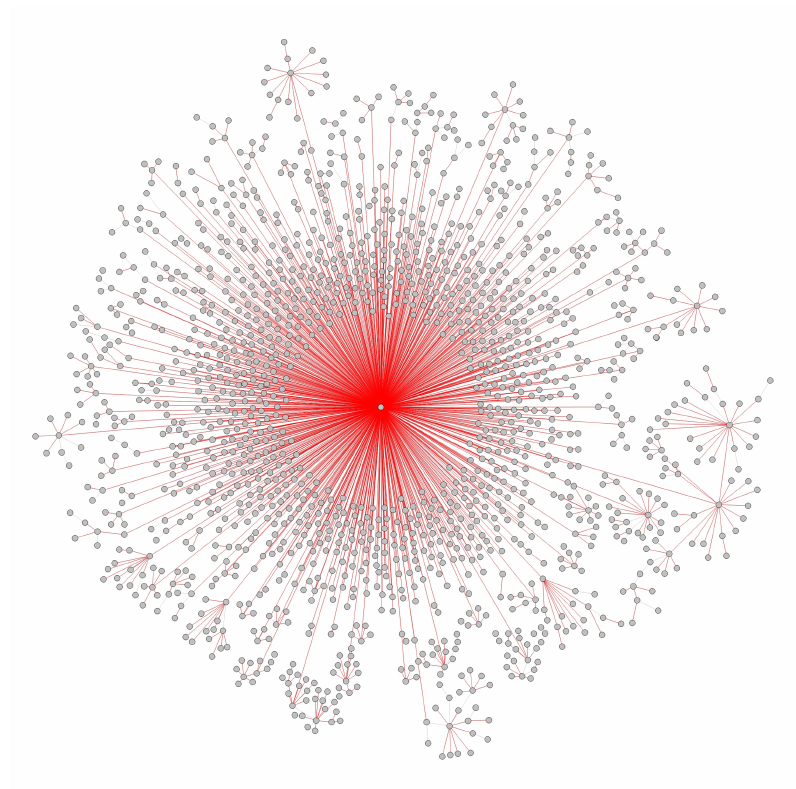
Figure A6. Abnormal edges in New York State transmission network.